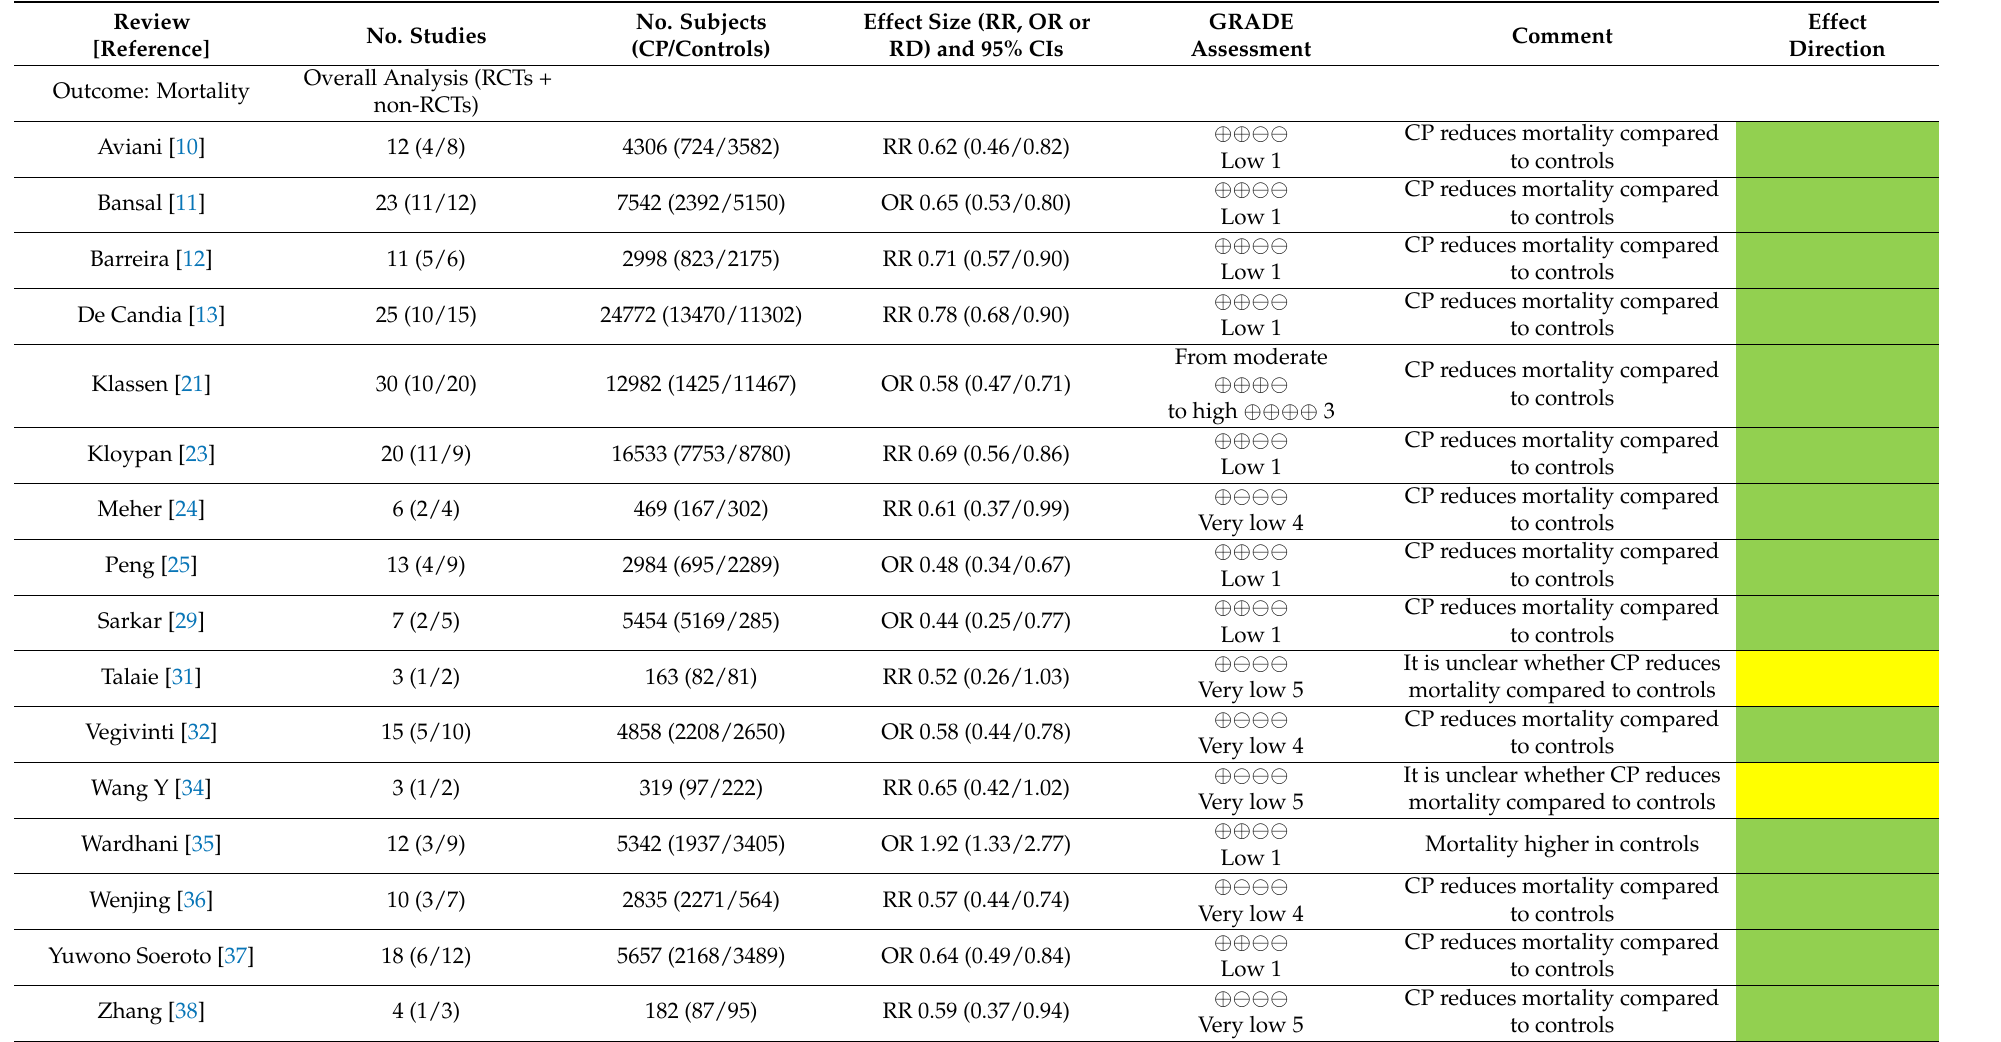
Table 3. Effects of convalescent plasma on overall